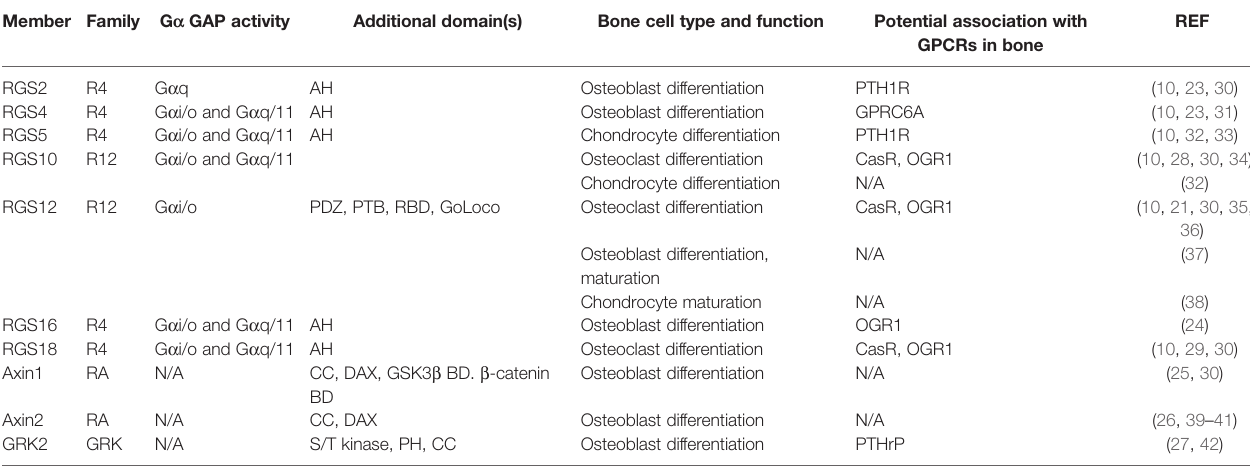
TABLE 1 | The impact of RGS proteins on bone homeostasis. Member Family G a GAP